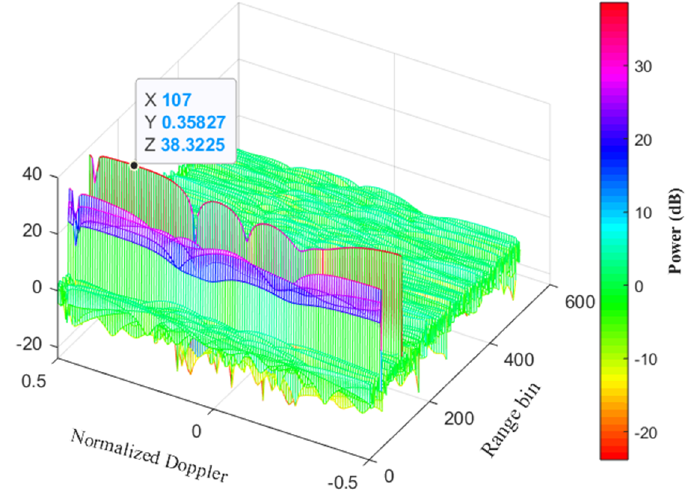
Figure 15. Range–Doppler projection of 3D processed data.